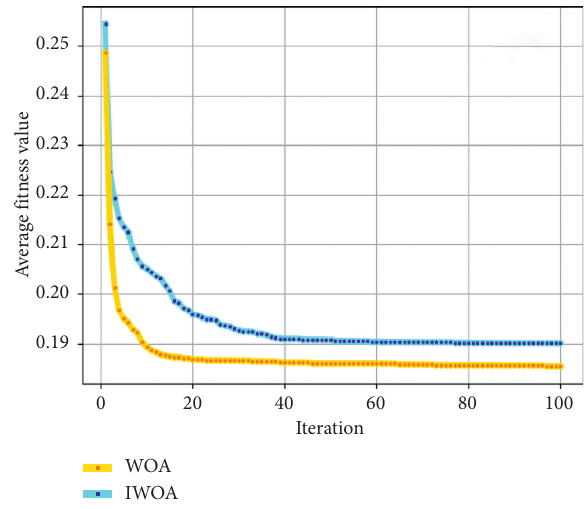
Figure 7: Convergence curves for WOA and IWOA. Table 2: Evaluation metrics for WOA and IWOA with the reli- ability range